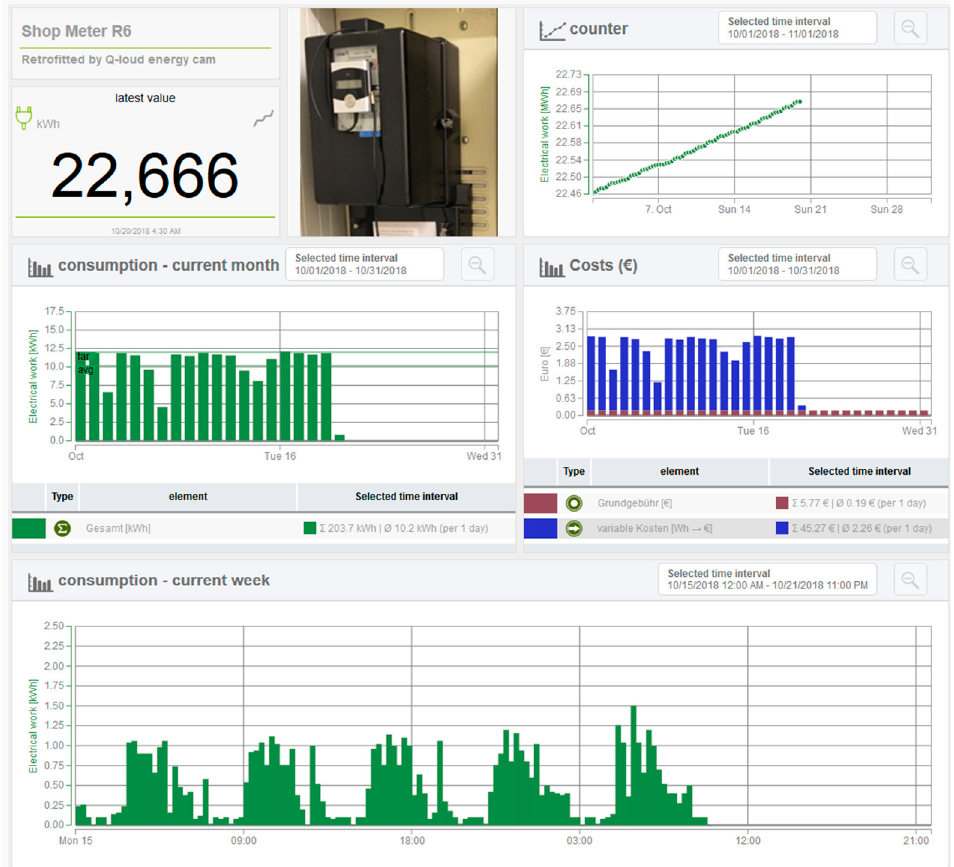
Figure 3. Screenshot of the resulting dashboard.